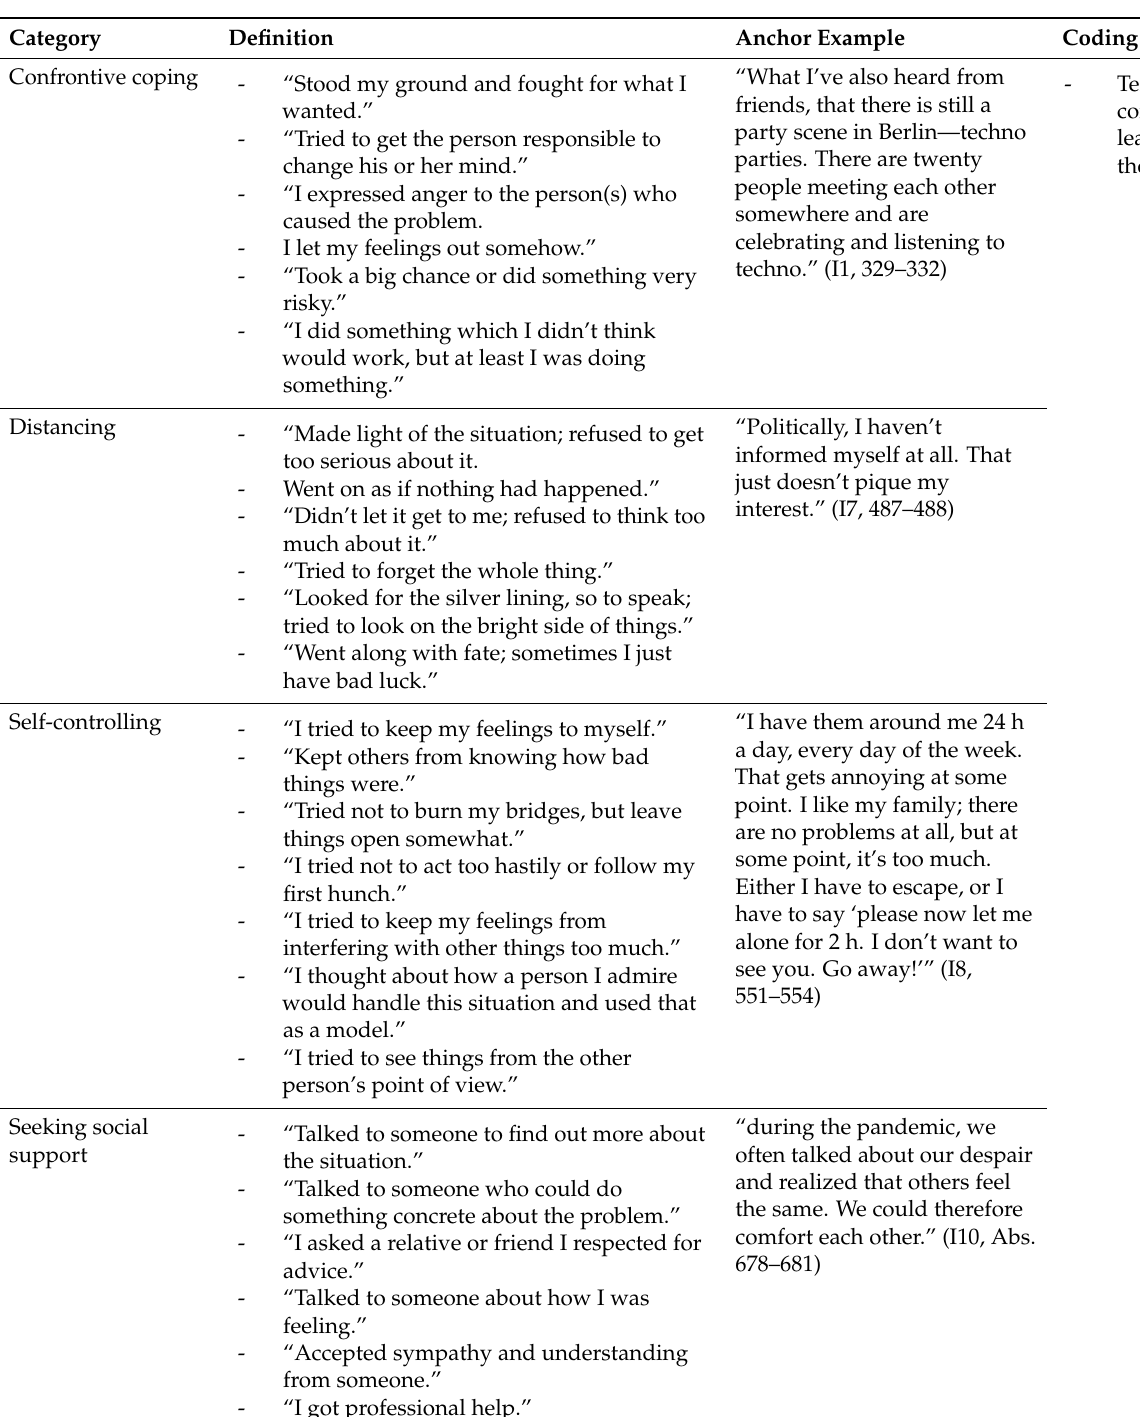
Table 2. Coding guideline according to Mayring [72,74] for deductive coding of coping strategies based on the theory of Folkman et al. [66] (pp.